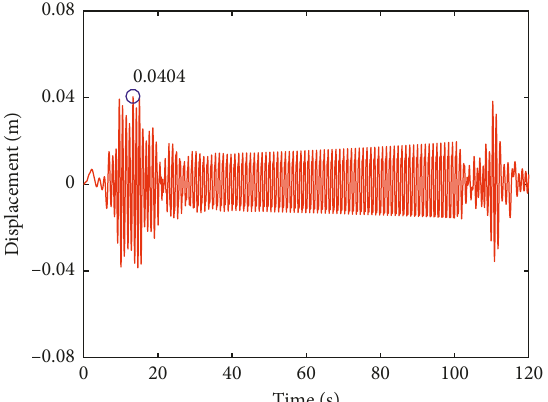
Figure 10: Total lateral vibration displacements at l c /2 of the cat- vertical rope in lowering.